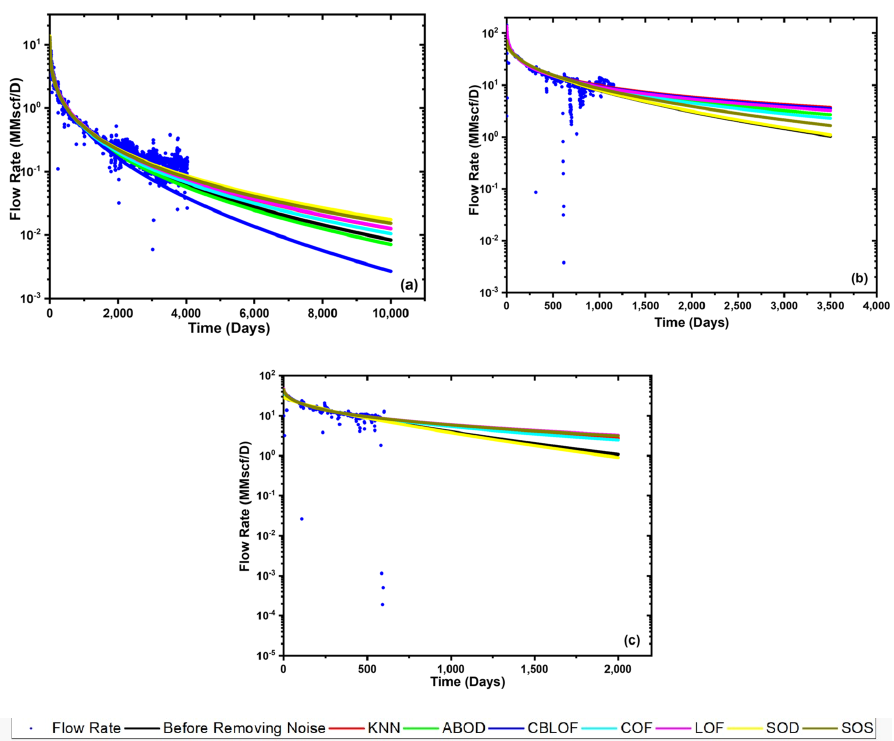
Figure 24. Applying VEDM decline model before and after removing noise using the seven OD algorithms for; ( a ) Well_12, ( b ) Well_29, and ( c ) Well_40.